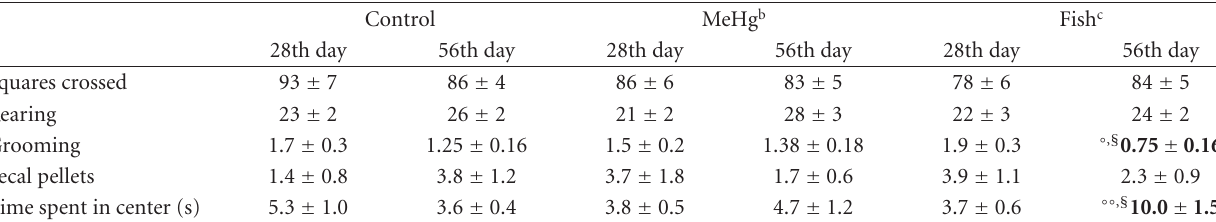
Table 4: Mice behavior in an open field maze a